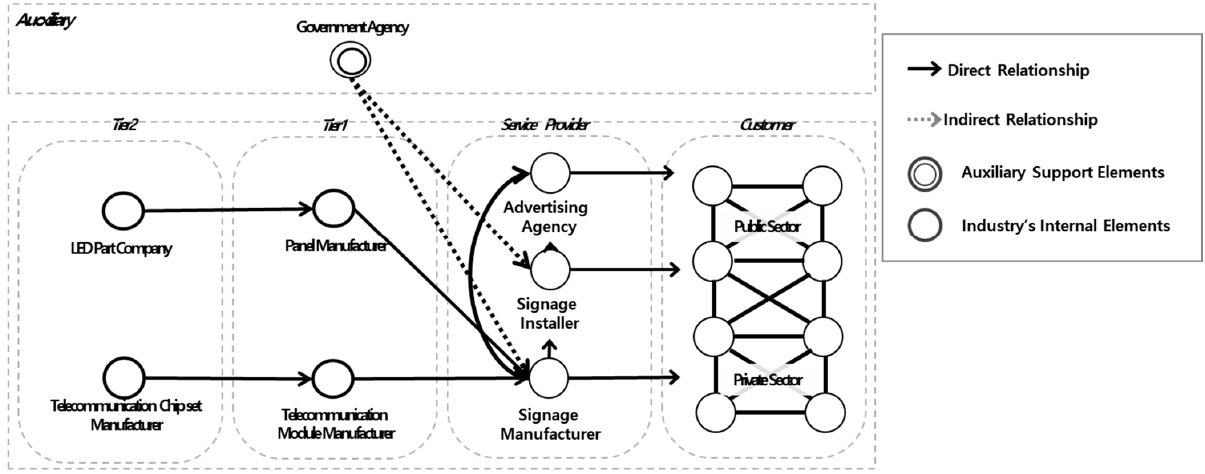
Figure 5. AS-IS model.